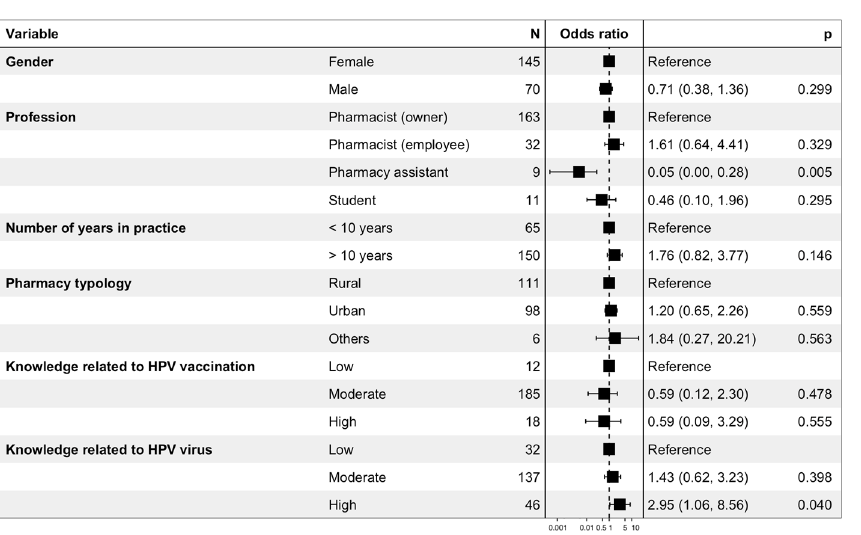
Figure 7. Binary logistic regression performed to evaluate the determinants of the right attitude toward HPV vaccination in girls. The right attitude toward HPV vaccination in girls corresponded to respondents that (i) found HPV vaccine useful for girls, (ii) considered that HPV vaccine was safe for girls, and (iii) had previously advised HPV vaccination to an 11–14 ‐ year ‐ old girl.